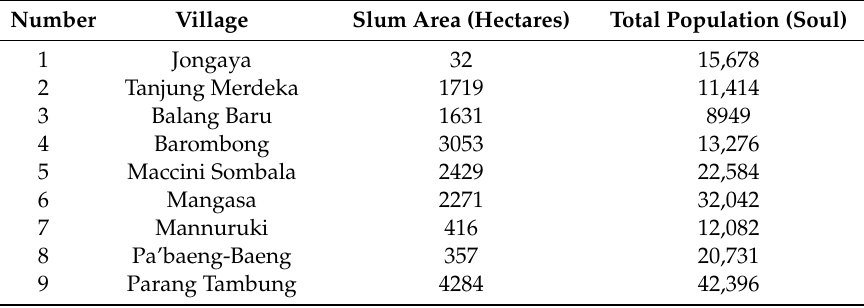
Table 3. Distribution of slums, population, and density of Tamalate